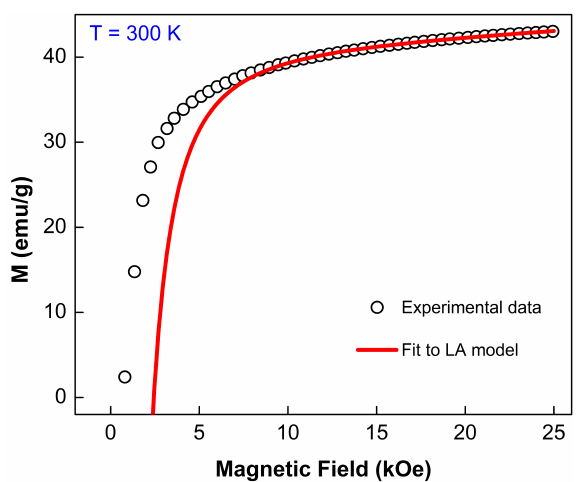
Figure 5. The magnetization curve (positive branch) at RT for the Cu 0.75 Co 0.25 Fe 2 O 4 ferrite nanopar- ticles fitted to the LA